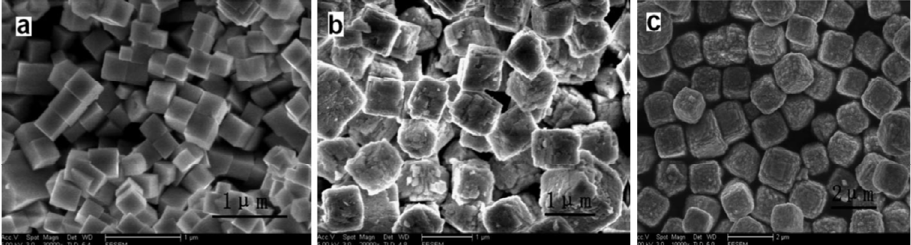
Figure 9. Particle size evolution in the manual grinding synthesis of zinc hydroxystannate. Scanning electron microscopy images of the product ZnSn(OH) 6 after: ( a ) 10 min; ( b ) 30 min, and ( c ) 1 h grinding [165] .